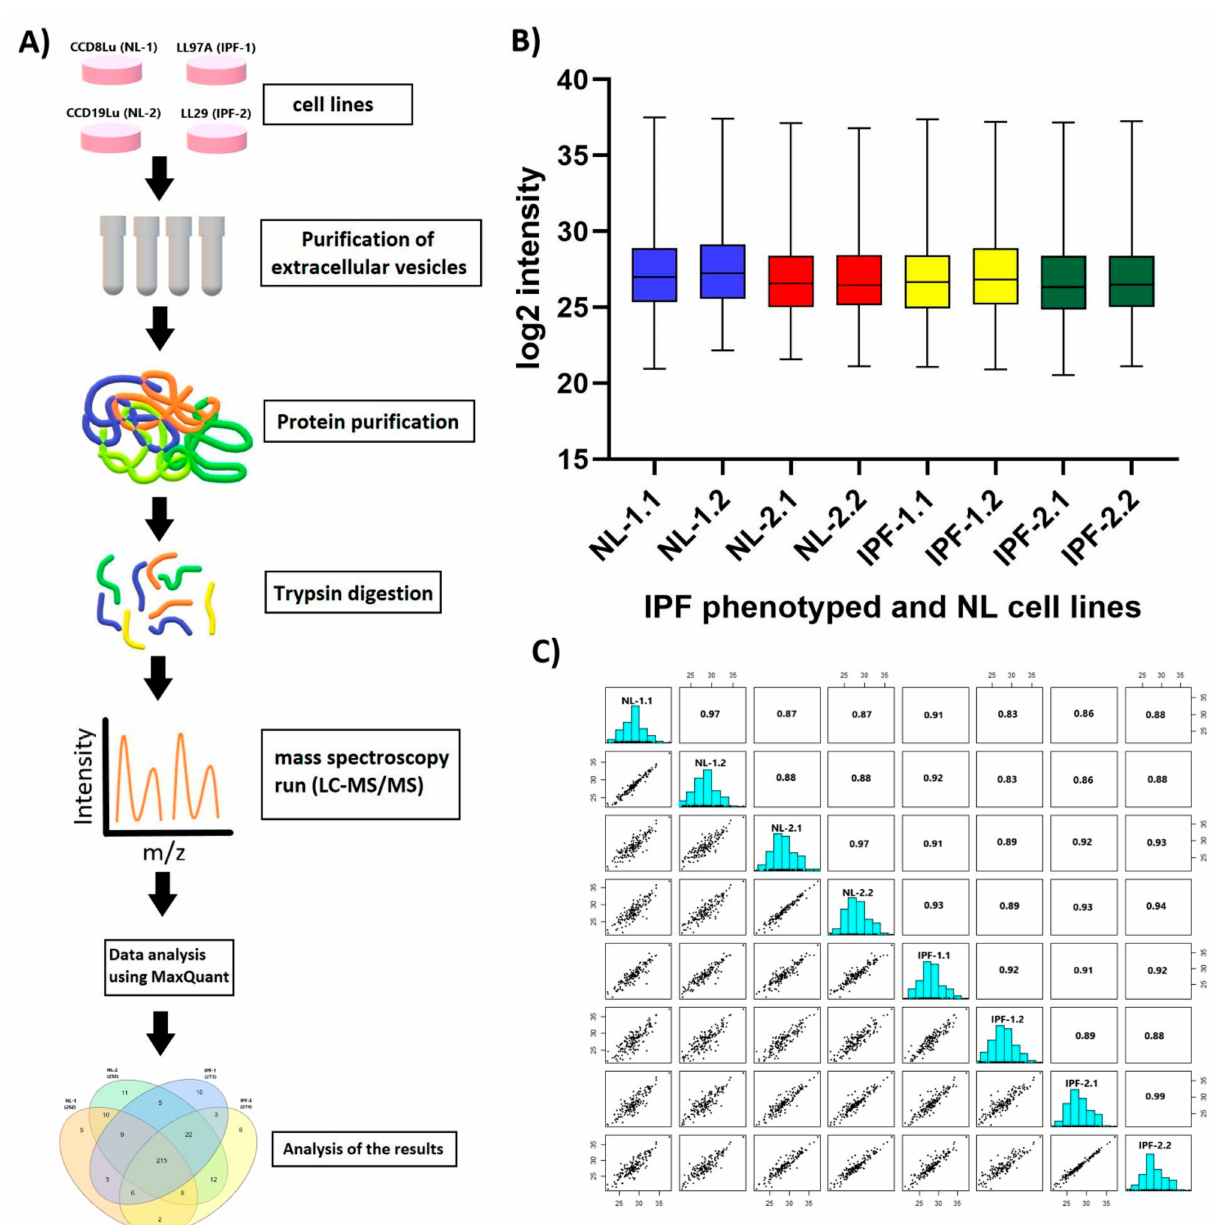
Figure 2. Experimental design of proteomic analyses and reproducibility of LC-MS/MS data. ( A ) Experimental workflow of proteomic analyses. ( B ) Box plot of biological replicates of each EVs sample obtained from each cell line. ( C ) Correlation plot of biological replicates per EVs sample obtained from each cell lines. IPF, idiopathic pulmonary fibrosis; NL, normal